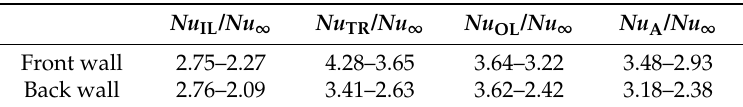
Table 1. Heat transfer enhancements of front and back endwalls of the present twin-pass parallelogram channel with detached